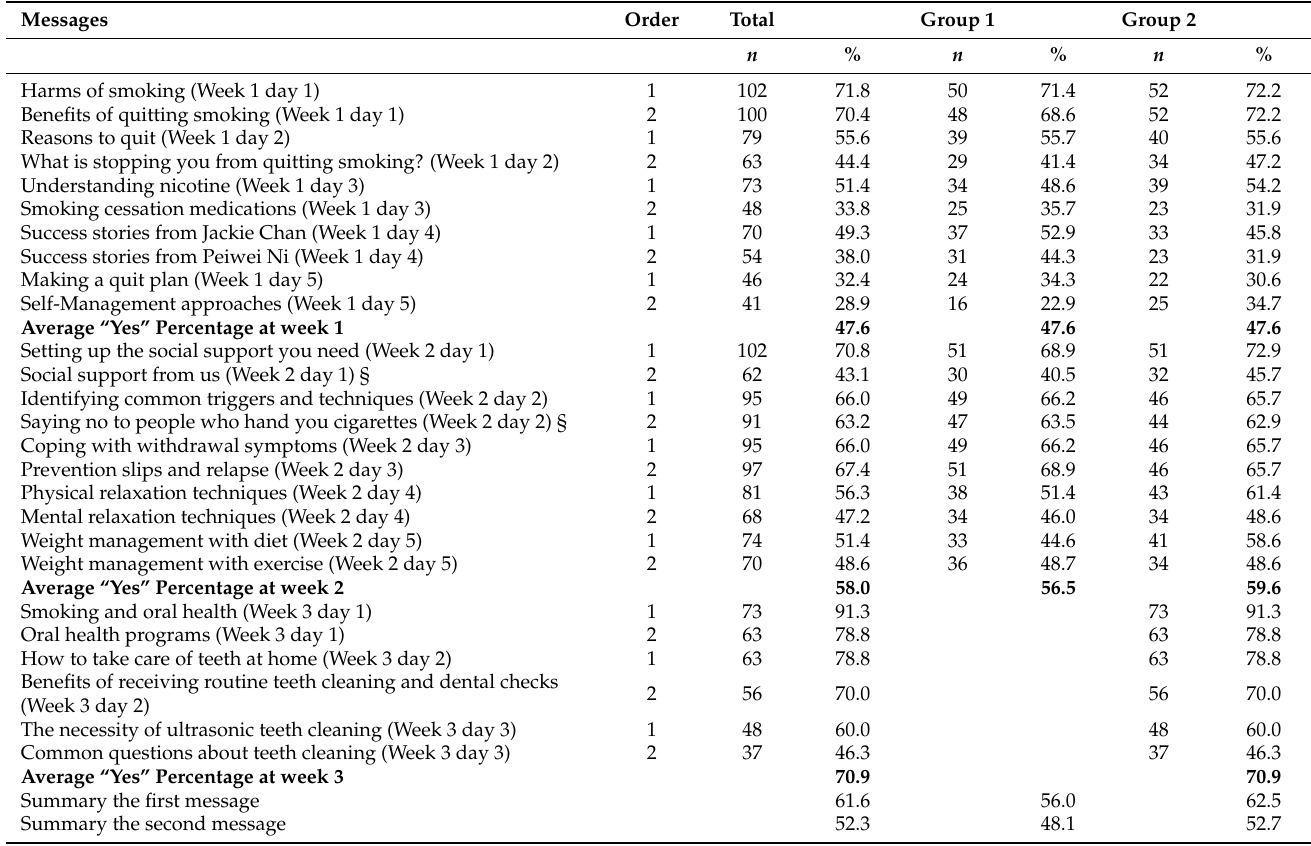
Figure 2A–C describe the percentage of participants who read messages between groups, respectively. For each week, as the week went on, fewer and fewer participants read intervention messages; moreover, within each single week, the number of participants who read the intervention messages gradually decreases over time. However, participants had a higher rate of reading intervention messages during the beginning part of each week. Picture-based intervention messages were less likely to be read than video-based intervention